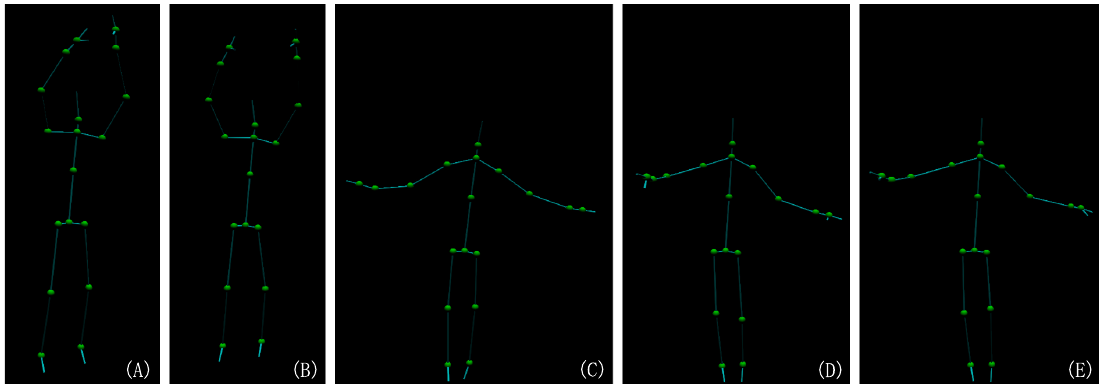
Figure 2. The motion skeleton captured by Kinect v2.0. It shows that the left and right part of the bone are obviously not the same length. In the images ( A , B ), the shoulder length and arm length are clearly not symmetrical and ( C – E ) the upper-leg and lower-leg are not symmetrical.